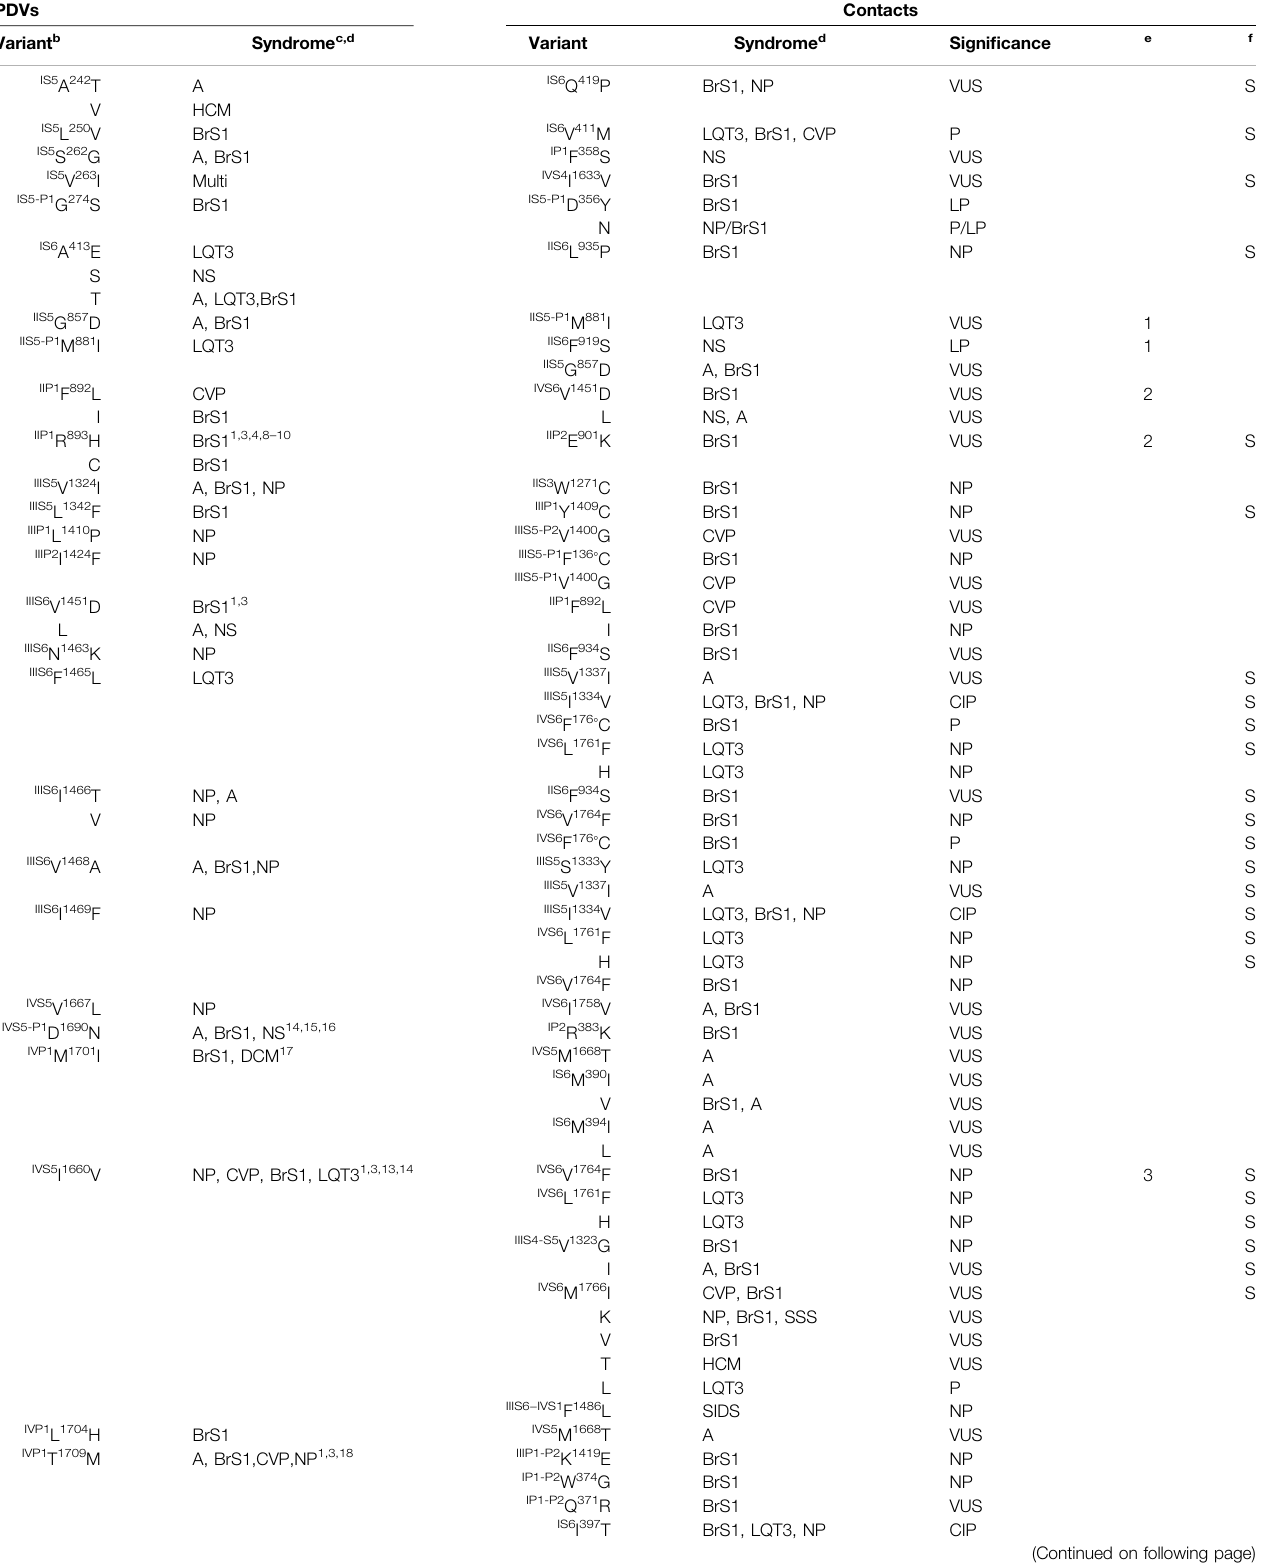
TABLE 1 | PDVs in the pore domain and their contacts a